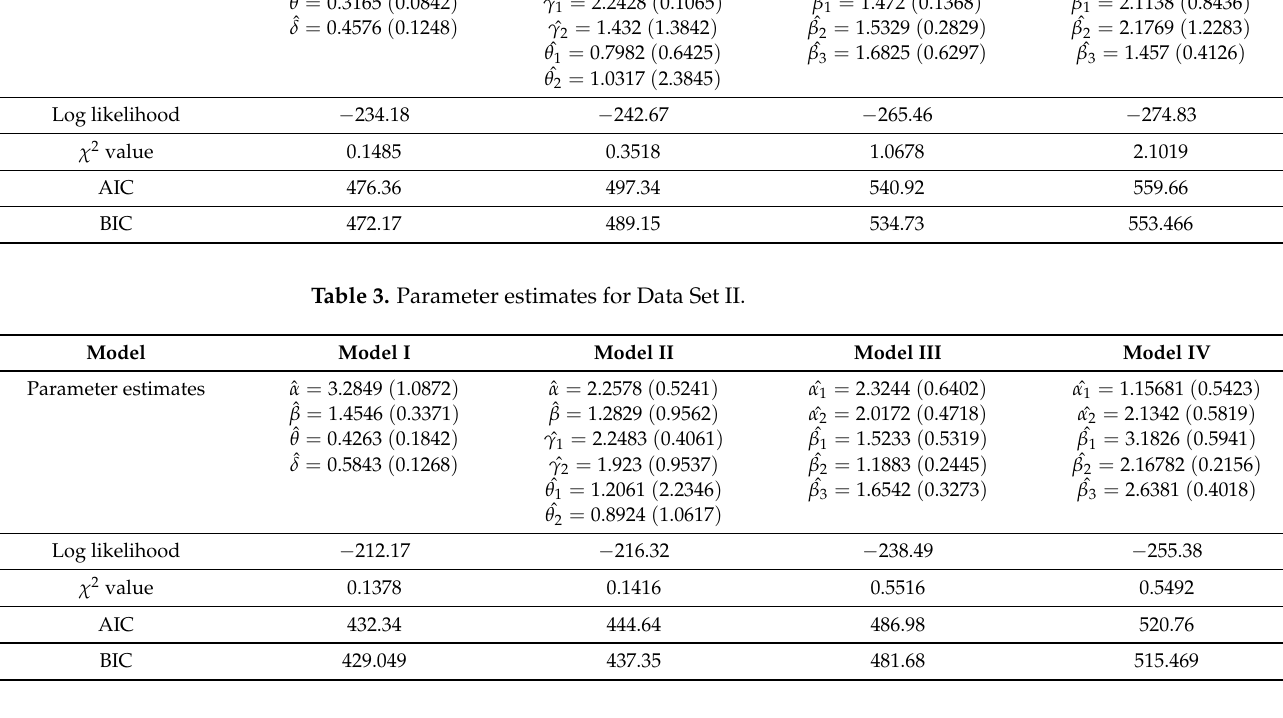
Table 4. Parameter estimates for Data Set I.